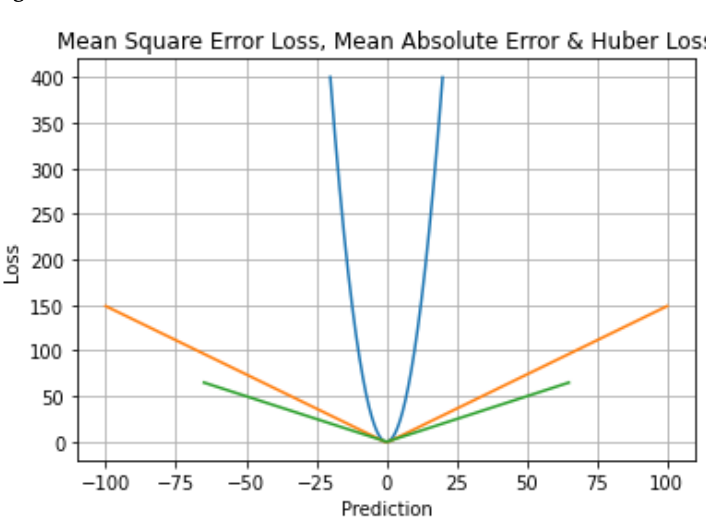
Figure 8. Mean Absolute Error loss & Huber loss.